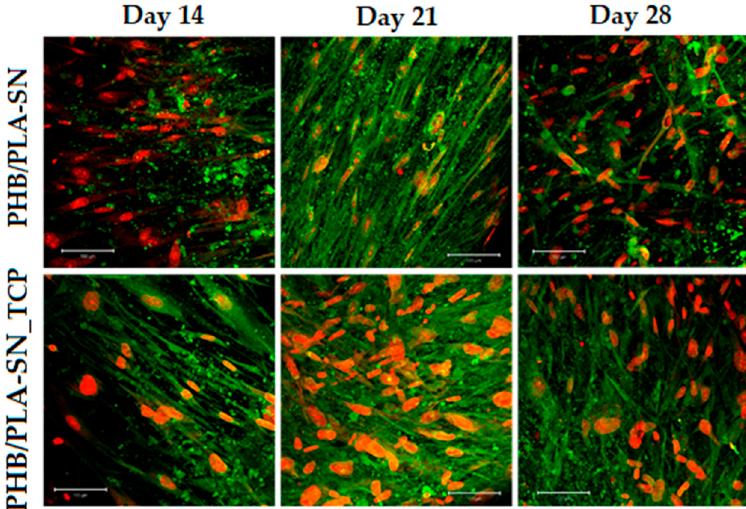
Figure 9. Osteocalcin staining, cell nuclei are red and osteocalcin green, magnification 200×, the bar is 100 µm.